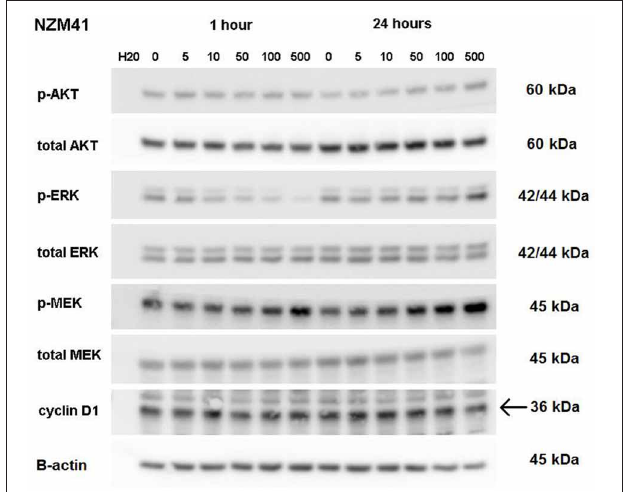
FIGURE 3 | Western blots showing pathway signaling in response to CI-1040 (nanomolar concentrations) for the NZM41 line (BRAF D549N mutation) at 1 and 24h. The arrow indicates the protein of interest in blots where non-specific bands are also present.